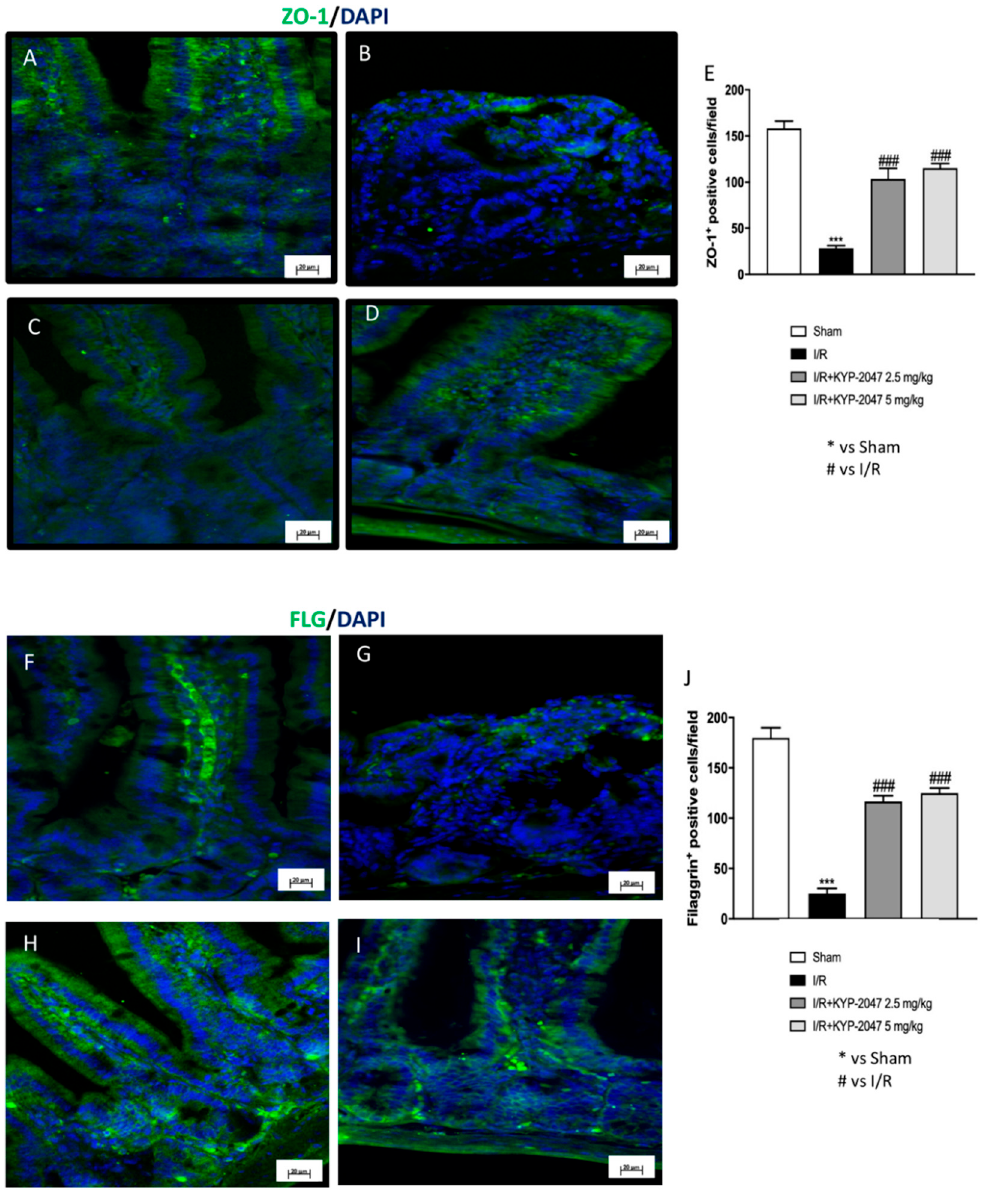
Figure 3. Effect of KYP-2047 administration on the expression level of ZO-1 and FLG by IF in intestine. ( A ) Control group intestinal cells’ immunoreactivity for ZO-1. ( B ) IRI animals showed a significant loss of intestinal ZO-1. ( C , D ) An increase in ZO-1 cells’ positivity was observed in IRI animals and subsequently treated with KYP-2047 (2.5 mg/kg and 5 mg/kg). ( E ) Immunofluorescence analysis of ZO-1. ( F ) The number of positive FLG cells was normal in the sham group. ( G ) A significant decrease in FLG cells’ positivity was observed in IRI animals. ( H , I ) KYP-2047 treatments (2.5 mg/kg and 5 mg/kg) increased FLG cells’ positivity in the intestine. ( J ) Immunofluorescence analysis of FLG. Data are representative of at least three independent experiments. *** p < 0.001 vs. Sham; ### p < 0.001 vs. IRI.